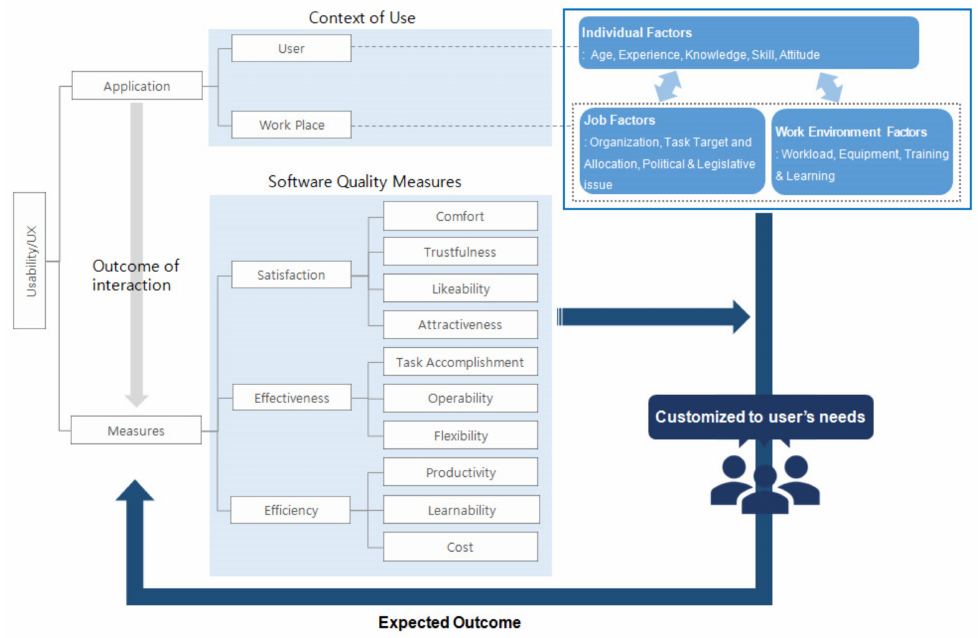
Figure 2. Factors affecting software usability and